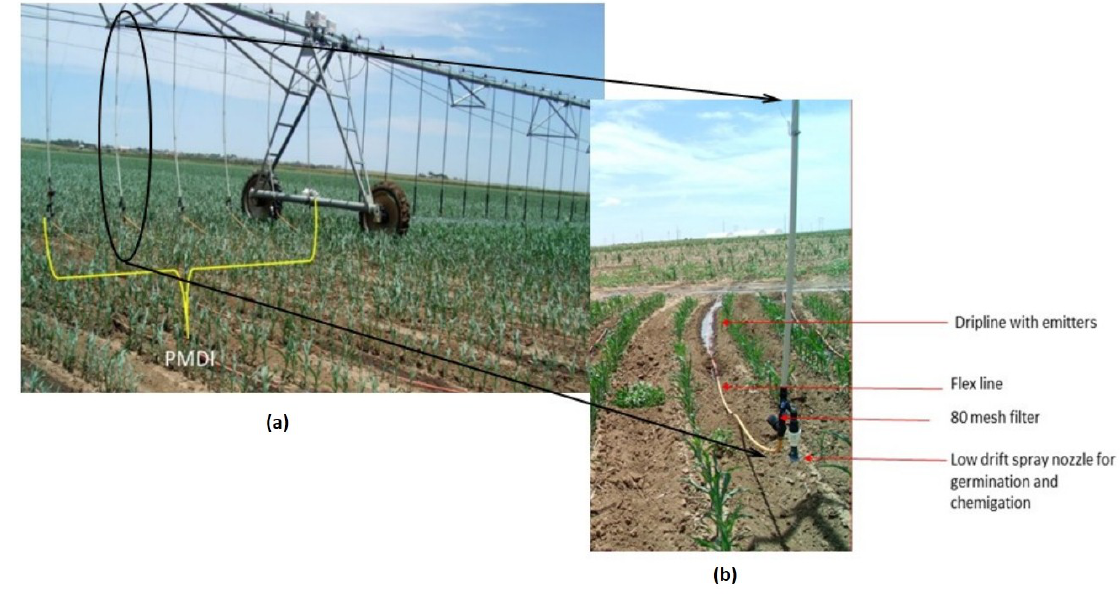
Figure 4. Precision mobile drip irrigation (MDI) system: ( a ) shown on span 1 to the left; and ( b ) zoomed-in view of one MDI drop showing sprinkler hardware, filter and dripline dragging